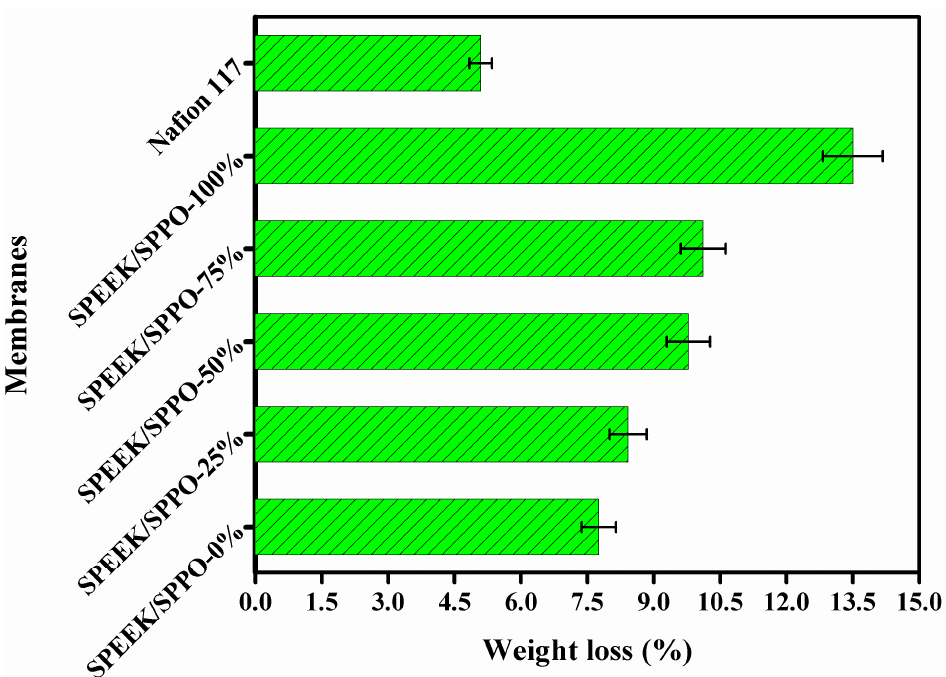
Figure 5. Weight loss of SPEEK, SPPO and SPEEK/SPPO blended membranes after immersion into Fenton’s reagent (3 wt% H 2 O 2 and 3 ppm Fe 2+ ) at 60 °C for two weeks (where 0, 25, 50, 75 and 100% represent the amount of SPPO into the SPEEK/SPPO blended membranes).